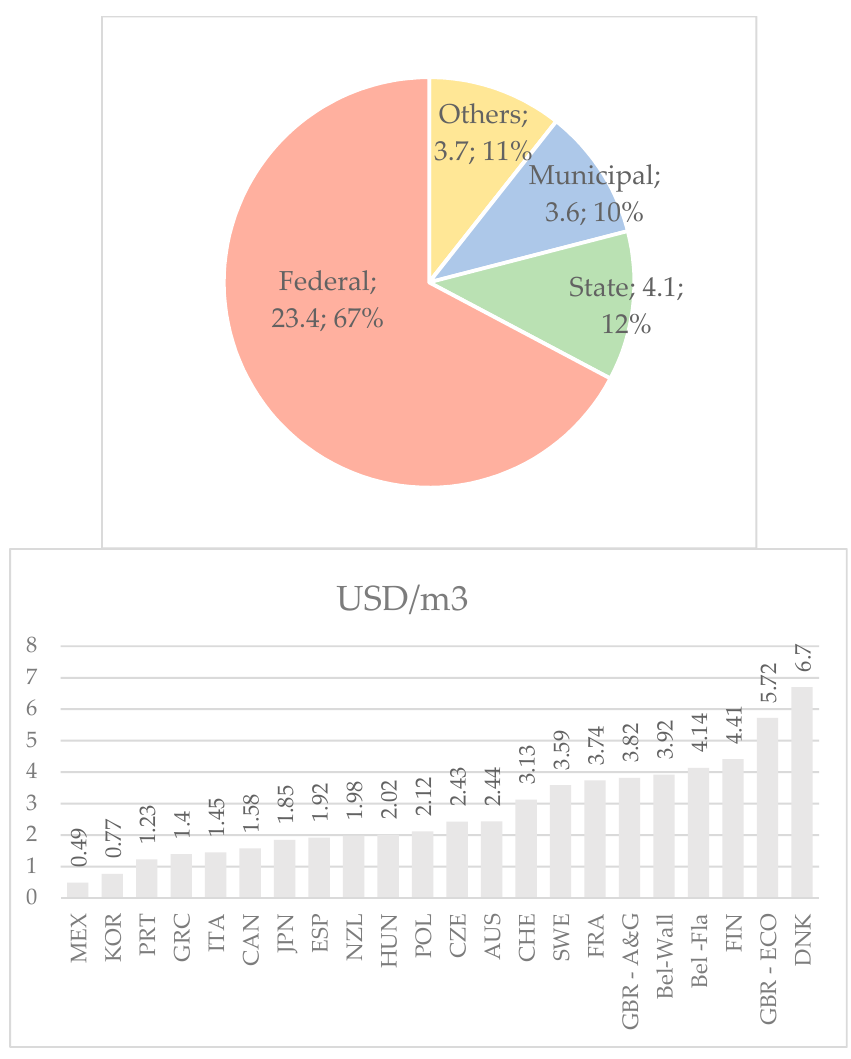
Figure 4. Investments by origin of resources in Mexico (left panel) and Unit price of water and sanitation services to households incl. taxes and subsidies (USD / m 3 ) (right panel). Source: Authors’ elaborating using data from CONAGUA [23]; and OECD,